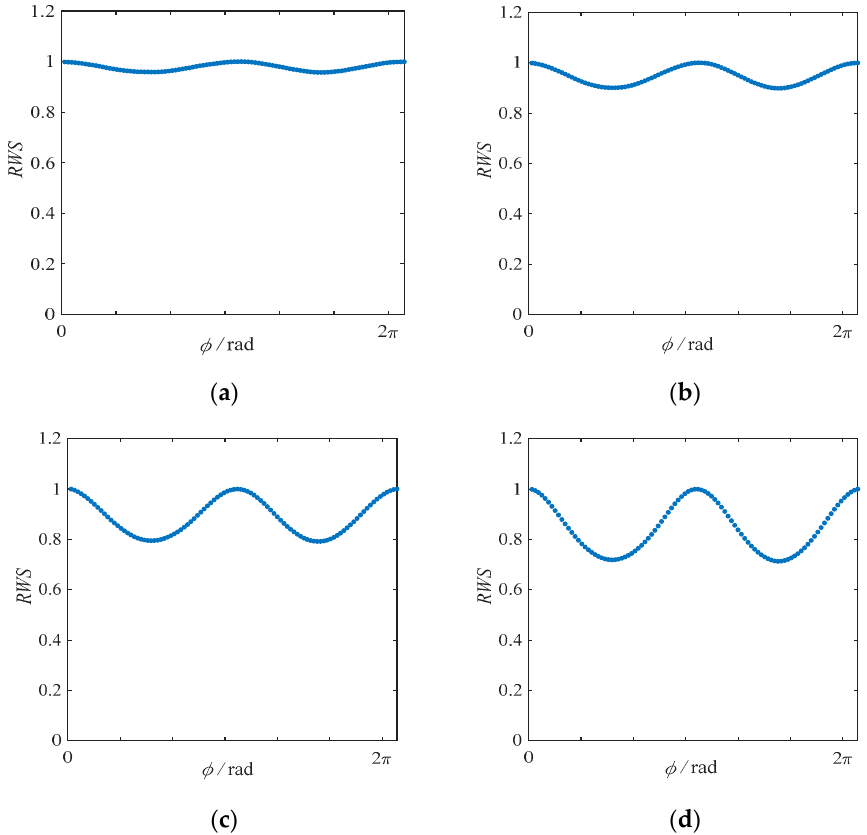
Figure 10. RWS for four crack depths: ( a ) μ = 0.05, ( b ) μ = 0.1, ( c ) μ = 0.2, ( d ) μ = 0.3.